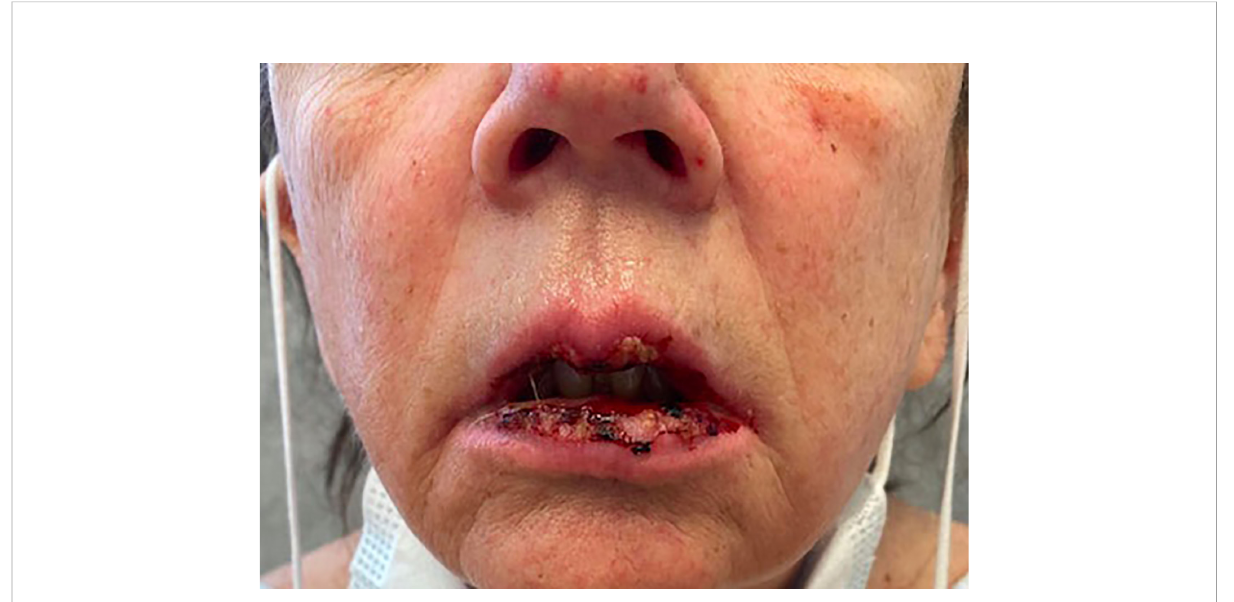
FIGURE 5 Patient ’ s mouth 11 days after initial